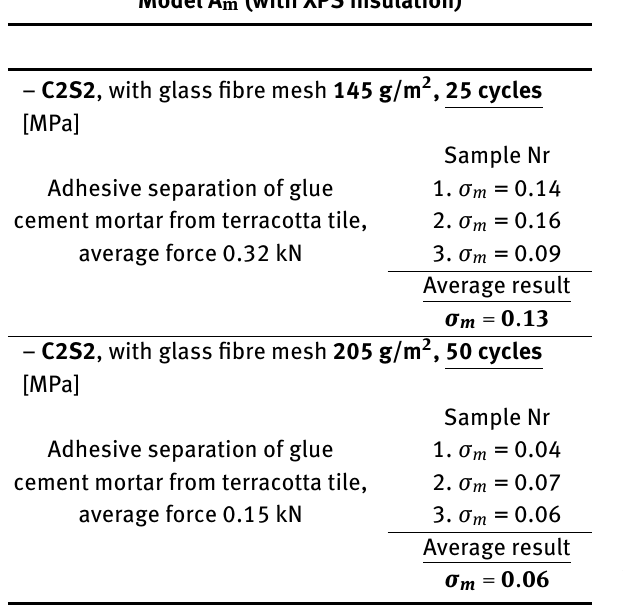
Table 2: The results of frost resistance tests Model A m (with XPS insulation)